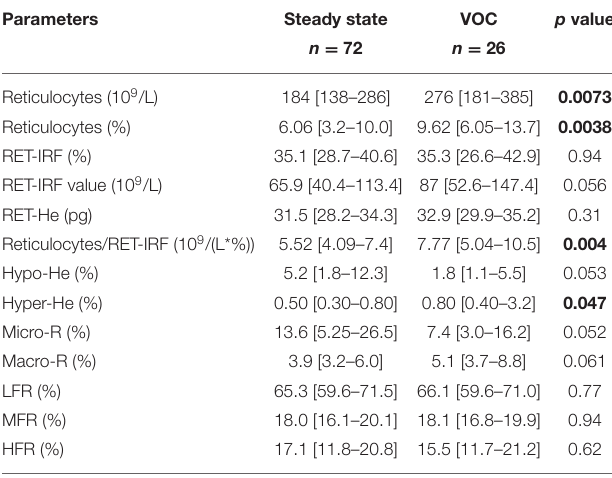
TABLE 3 | Comparison of biologic parameters in SCD patients developing or not a VOC in the following year. SCD without VOC development n =